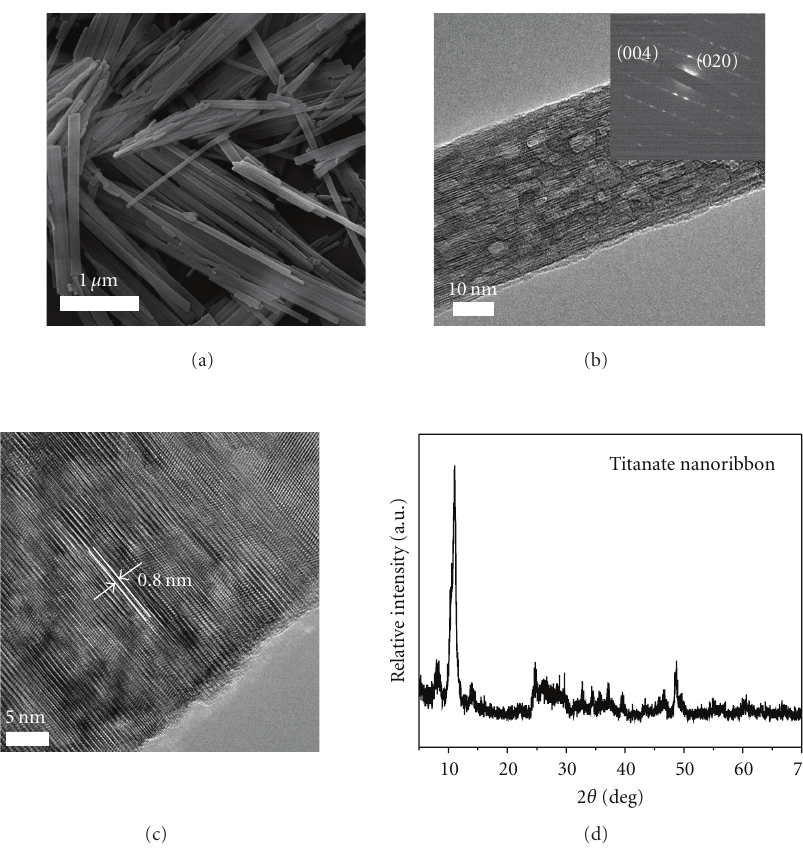
Figure 1: SEM image (a), TEM image (b), SAED pattern (inset in b), HRTEM image (c), and XRD pattern (d) of the as-prepared titanate